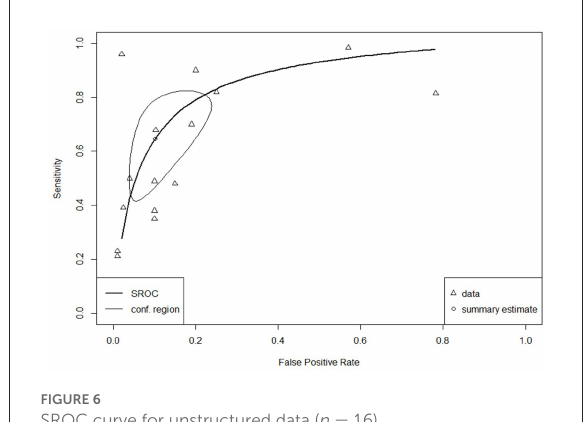
FIGURE6 SROC curve for unstructured data ( n = 16).